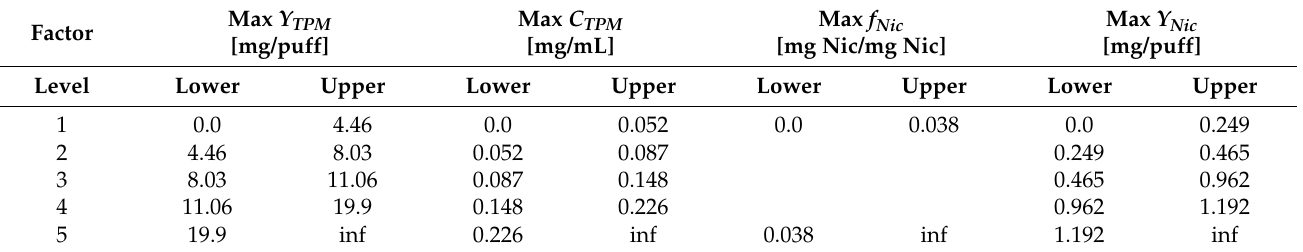
Figure 7. Interval plot for the maximal emissions characteristics demonstrating quantitative compari- son between products. Results are sorted within each figure in order of increasing maximal value plus the upper 95% confidence bound from left to right. The “+” marker between successive data points indicates there is a significant difference between maximal product emissions ( p < 0.05). Table 4. The lowest five statistically significant differences between maximal emissions characteristics observed across the thirteen product combinations